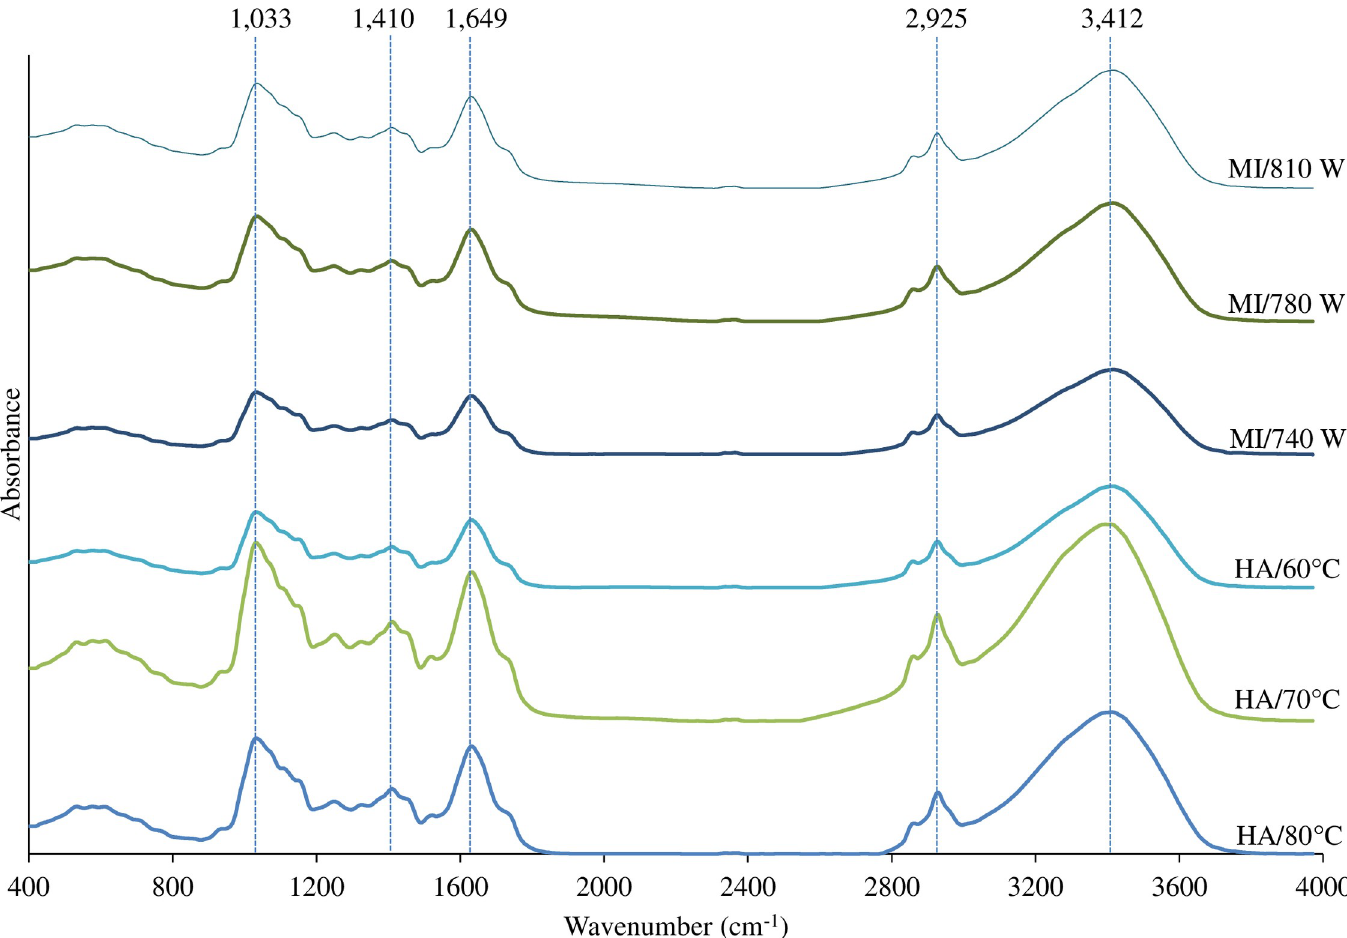
Fig 4. FTIR spectra of Tai-Pla curry paste (fresh sample) and Tai-Pla curry powder (TCP) dried using hot air (HA) and hybrid microwave-infrared drying (MI) under different drying conditions.